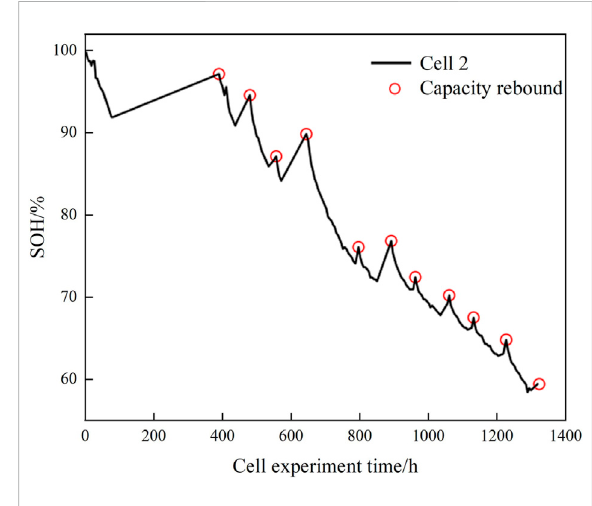
FIGURE 4 Cell one rest time greater than threshold cycle mark.